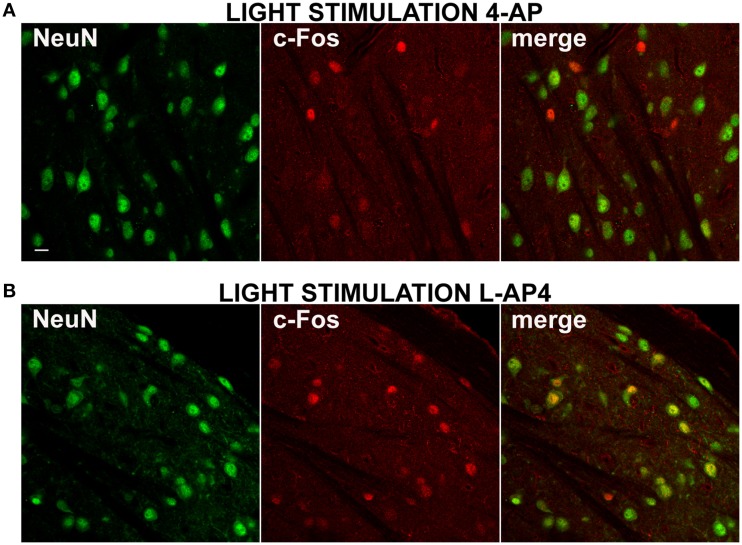
Differential activation of NeuN positive neurons by 4-AP and L-AP4. (A,B) Double immmunostaining for the neuronal marker NeuN (left) and the activity marker c-Fos (middle) and the merge image (right) in the dorsal portion of the lateral geniculate nucleus. Rats were injected into the eye with 4-AP (2 mM; A) and L-AP4 (2 mM; B). In (A,B) dLGN NeuN and c-Fos images were obtained from the same optical section of contralateral hemisphere. Notice how with 4-AP, almost all c-Fos positive cells are NeuN negative or weakly positive. The opposite is seen with L-AP4, where most active cells are NeuN positive. Magnification, 63×. White calibration bar, 10 μm.